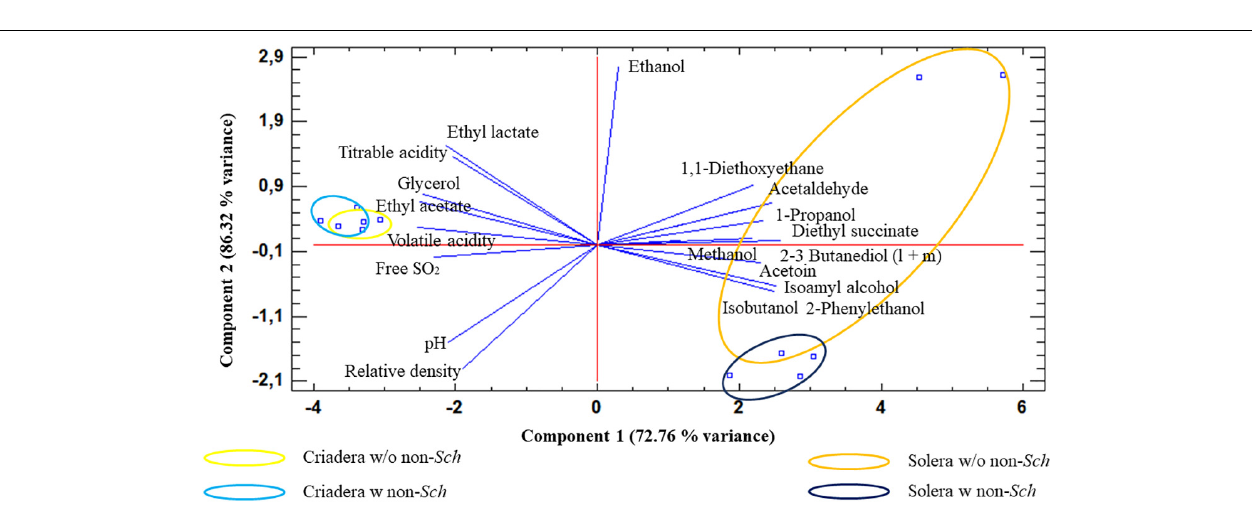
FIGURE 5 | Cluster analysis of wines with different aging times and the presence of non- Saccharomyces yeast. The analysis was carried out with all studied variables. Sol w/o non- sch , Solera wine without non- Saccharomyces ; Sol w non- sch , Solera wine with non- saccharomyces ; Cri w/o non- sch , Criadera wine without non- Saccharomyces ; Cri w non- sch , Criadera wine with non- Saccharomyces .